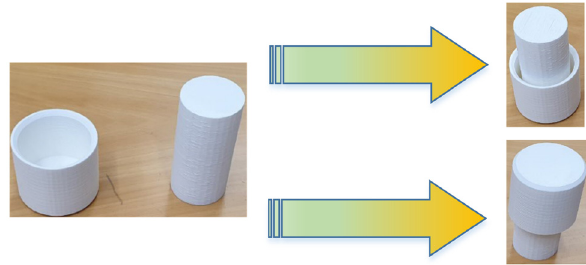
Figure 9: Generic assembly instruction PegInHole compared with “ peg - in - hole ” ( upper right ) and “ hole - in - peg ” ( lower right )